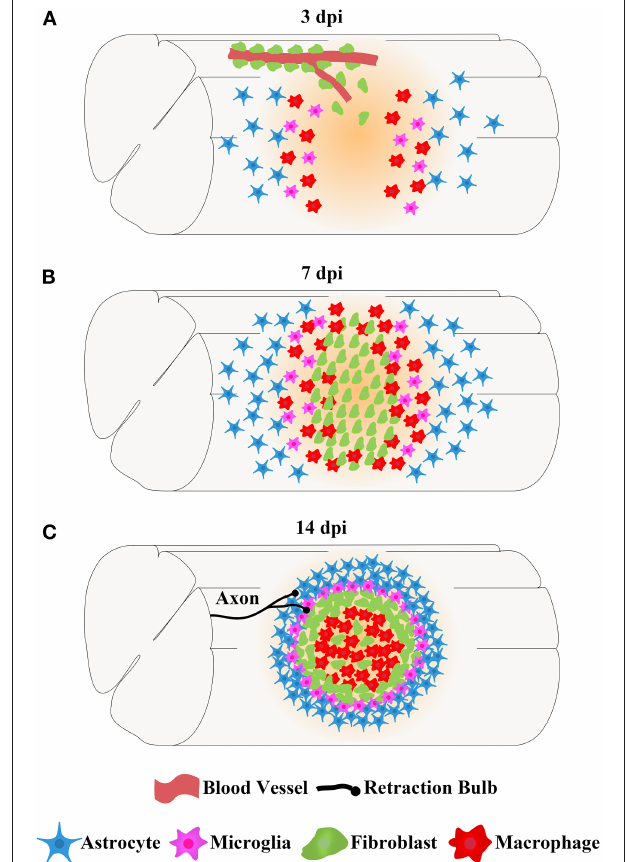
FIGURE 2 | The spatiotemporal distribution of scars after spinal cord injury. After SCI, astrocytes, microglia, fibroblasts, and macrophages contemporaneously proliferate, migrate, and aggregate at the injured core. Finally, the cells work together to form complex, mature, and stable structures that fill the entire injured core, which is maintained in the chronic phase of SCI. (A) At 3 dpi, fibroblasts leave the blood vessels and are dispersed in the injured area together with astrocytes, microglia, and macrophages. (B) At 7 dpi, the numbers of fibroblasts, astrocytes, microglia, and macrophages are significantly increased, and these cells aggregate at the injured core. (C) At 14 dpi, astrocytes form the astrocytic scar that are distributed in the outer layer and surrounding the entire injured core. Fibroblasts form a fibrotic scar adjacent to the medial side of the astrocytic scar and corral the macrophages in the injured core. Microglia are located between the astrocytic scar and fibrotic scar, while macrophages are located at the most central site of the injured core. The axon tips form retraction bulbs after contacting fibroblasts and fail to penetrate the dense barrier formed by the fibrotic scar at the edge of the injured core, resulting in the failure of axonal